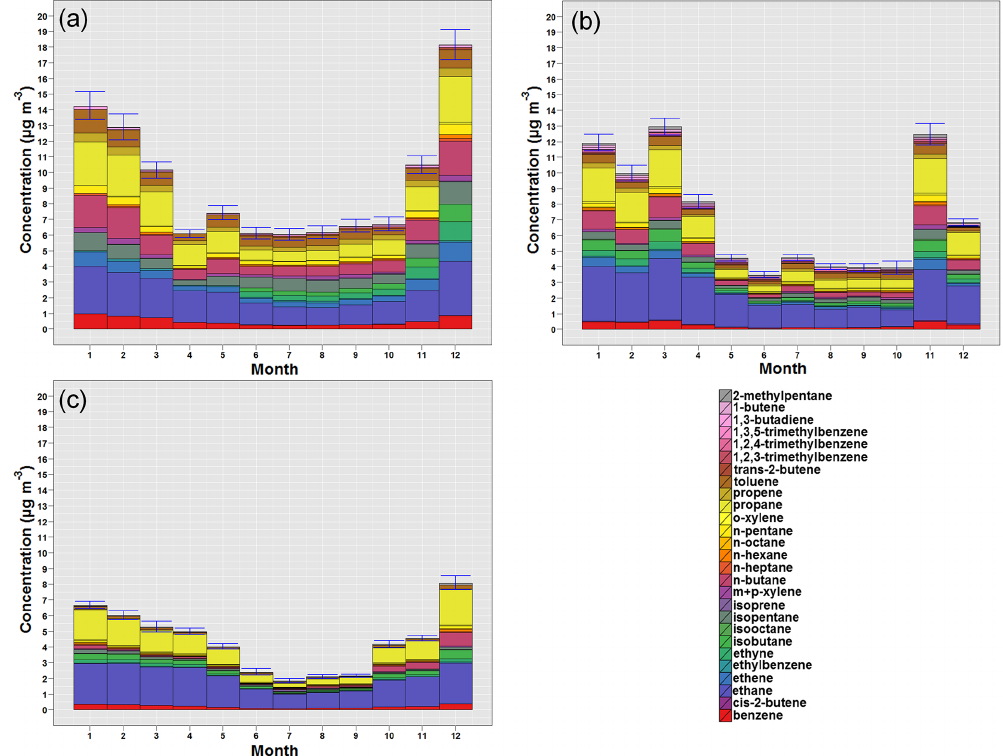
Figure 5. Stacked bar chart of median VOC concentrations at (a) Harwell 2001, (b) Harwell 2011, and (c) Auchencorth (2012). The error bars show the sum of the 95th percentile confidence interval in the median VOC concentrations. This represents the error introduced by representing the data set with the chosen fitted distribution (see